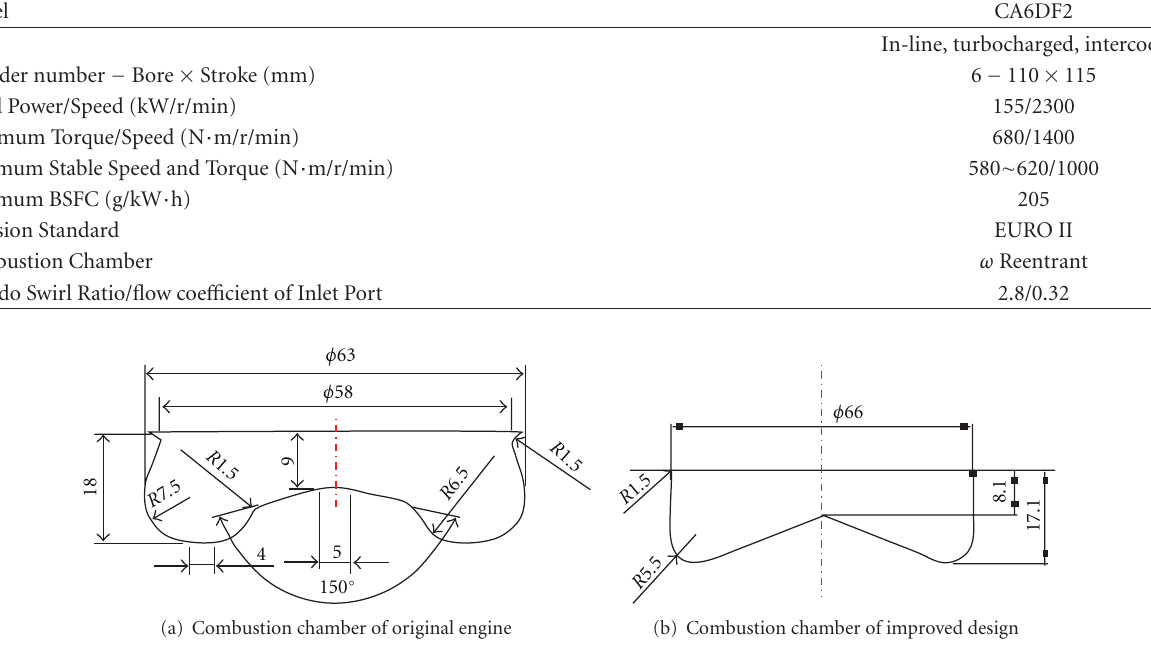
Figure 3: Combustion chamber